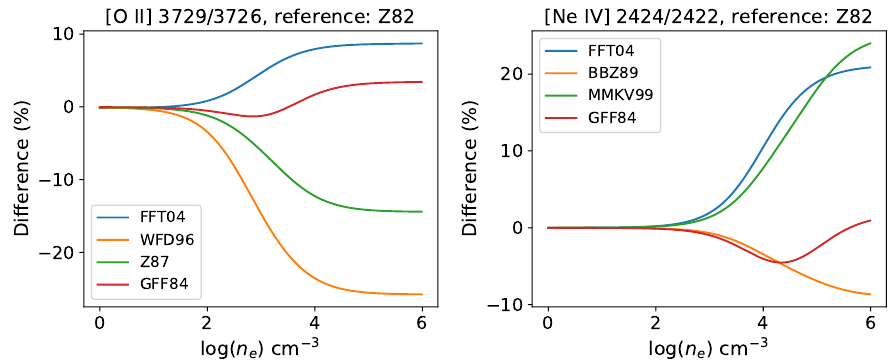
− 4 S o ) / ε ( 2 D o − 4 S o ) density-sensitive emissivity ratio of 5/2 3/2 3/2 3/2